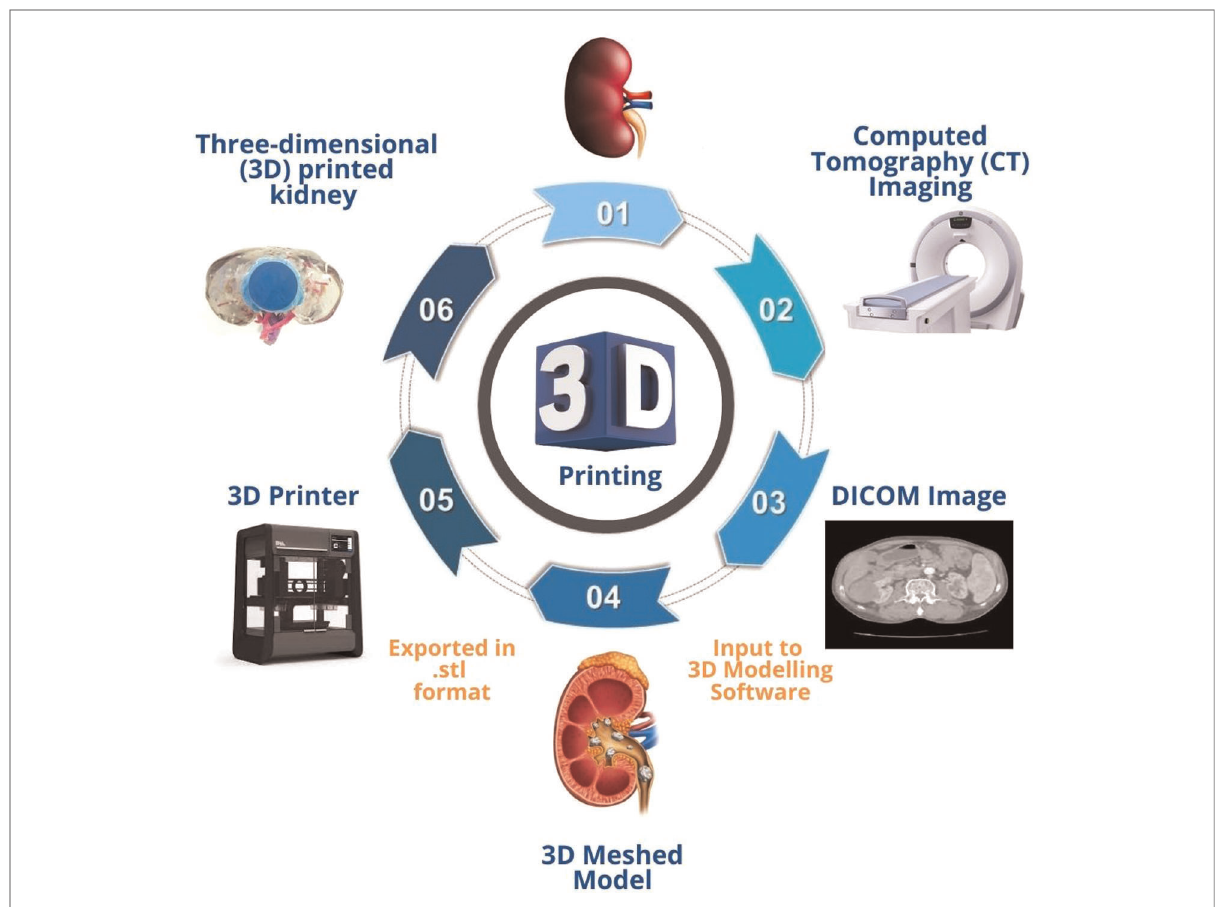
FIGURE 1 Process involved in three-dimensional (3D) printing of patient-speci fi c kidney